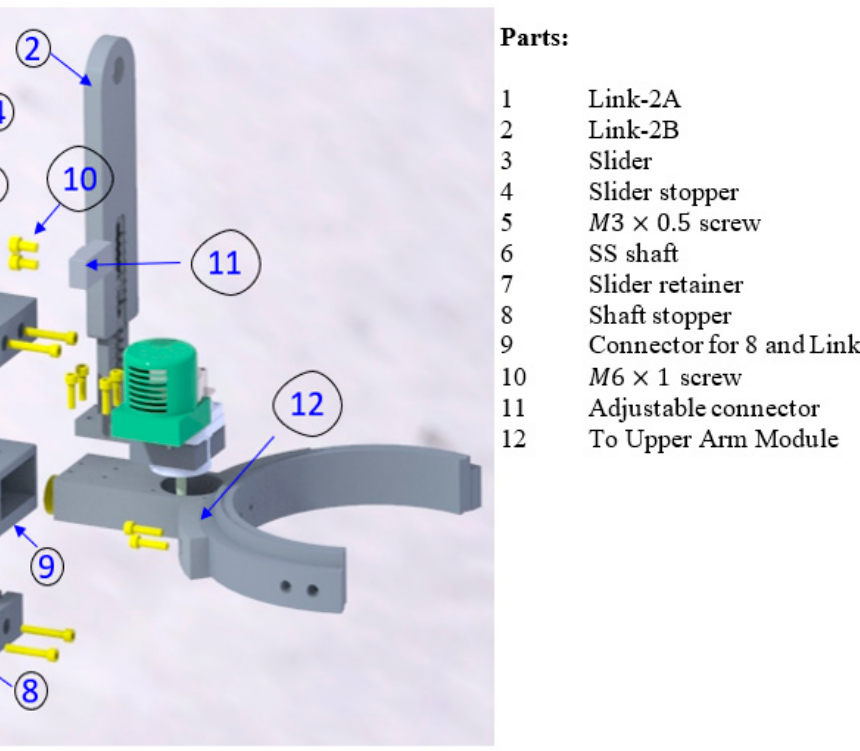
Figure 8. Exploded view of the upper arm sensorized cuff assembly. The inner cuff was machined in both a lathe and a computer numerical control (CNC) mill; an aluminum 6061 hollow round bar was used in the fabrication. The user cuff was 3D printed; hence, it can be easily made for different user sizes. The semi-circular spur gear was machined out of stainless steel.